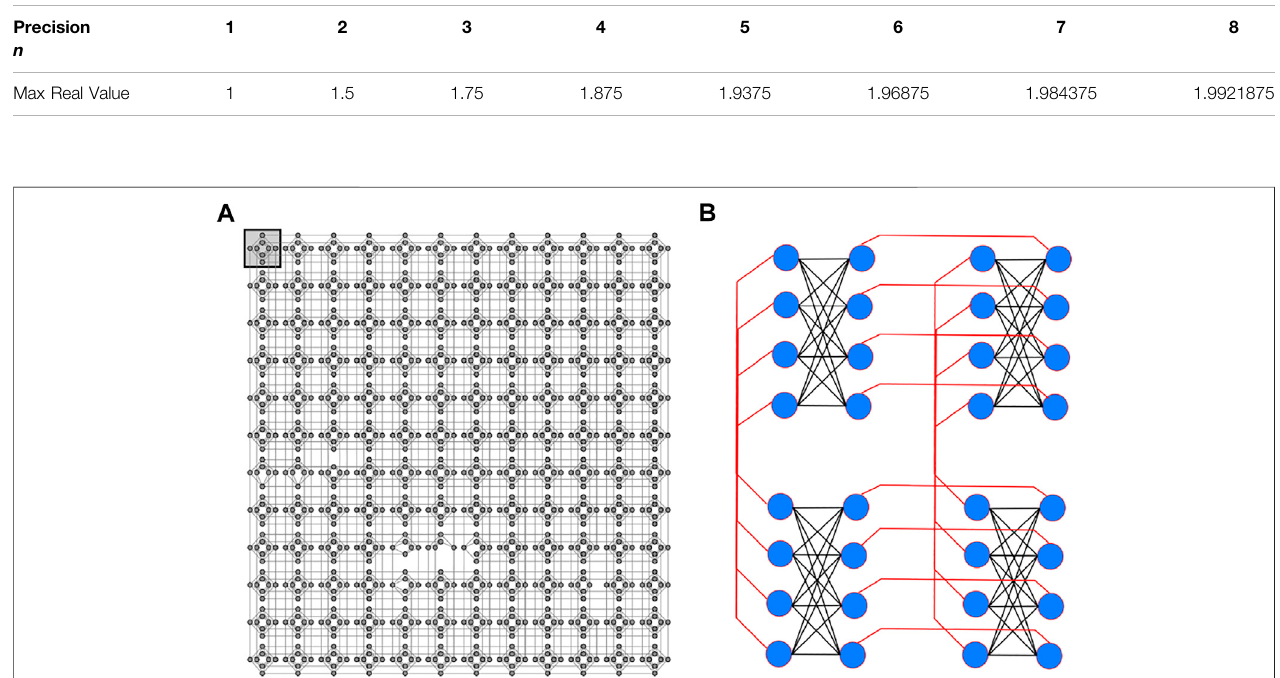
FIGURE 2 | (A) DWave Hardware Chimera Graph, showing the layout of the physical qubits in DWave annealer. Each block in the Chimera graph is K 4 graph. (B) Schematic of a unit block showing a schematic of a four block con fi guration where the blue represents a qubit with the coupling between adjacent blocks shown in red.